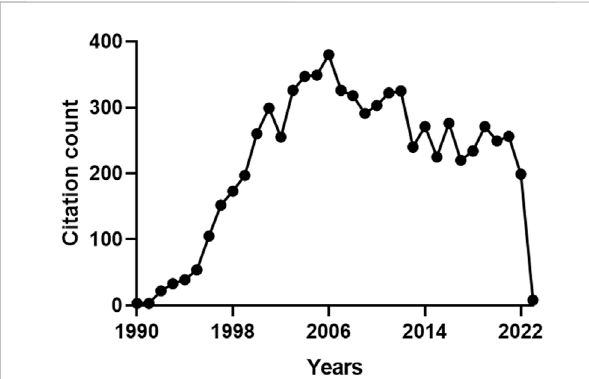
FIGURE 3 Annualnumberofcitationsreceivedbythepublicationsonheme oxygenase-2 (HO-2). The total citation count received by the 159 papers focusing on HO-2 was 7331. A multimodal pattern of distribution over the years can be identi fi ed: an early phase (1990 – 1994) characterized bya low count (100citations),followedby a sharp increase over the next 11 years (2517 citations), a peak in 2006 and a progressive decrease, starting in 2007 and still persisting. For further information, see